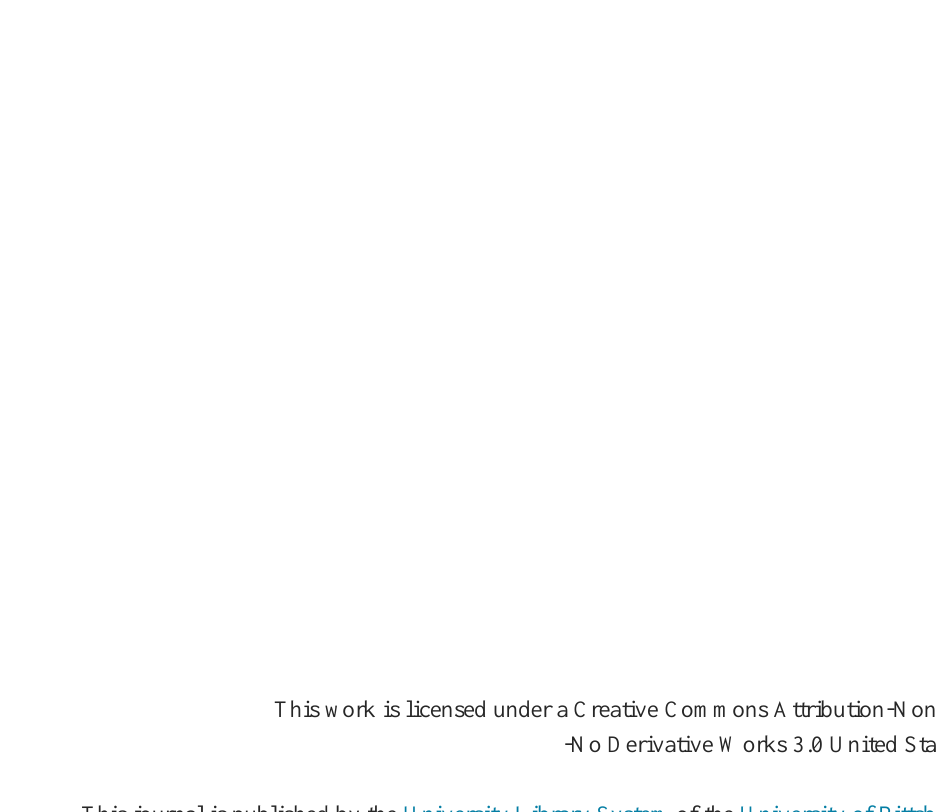
Overall Male Female OR P n (%) n (%) n (%) 861 (61.2) 407